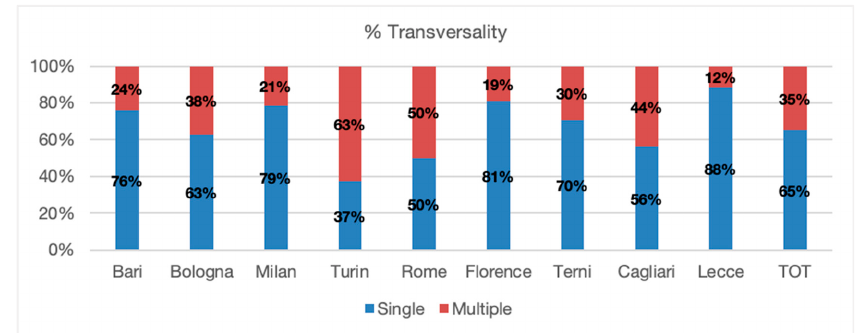
Figure 6. Single vs. multiple application domains projects.